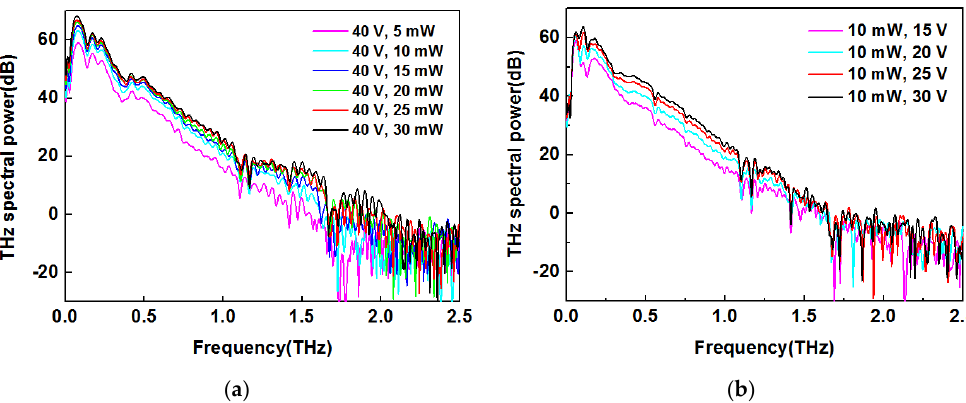
Figure 9. The measured THz power spectrums of the proposed PCA as a function of the ( a ) optical pump power and ( b ) bias voltage.